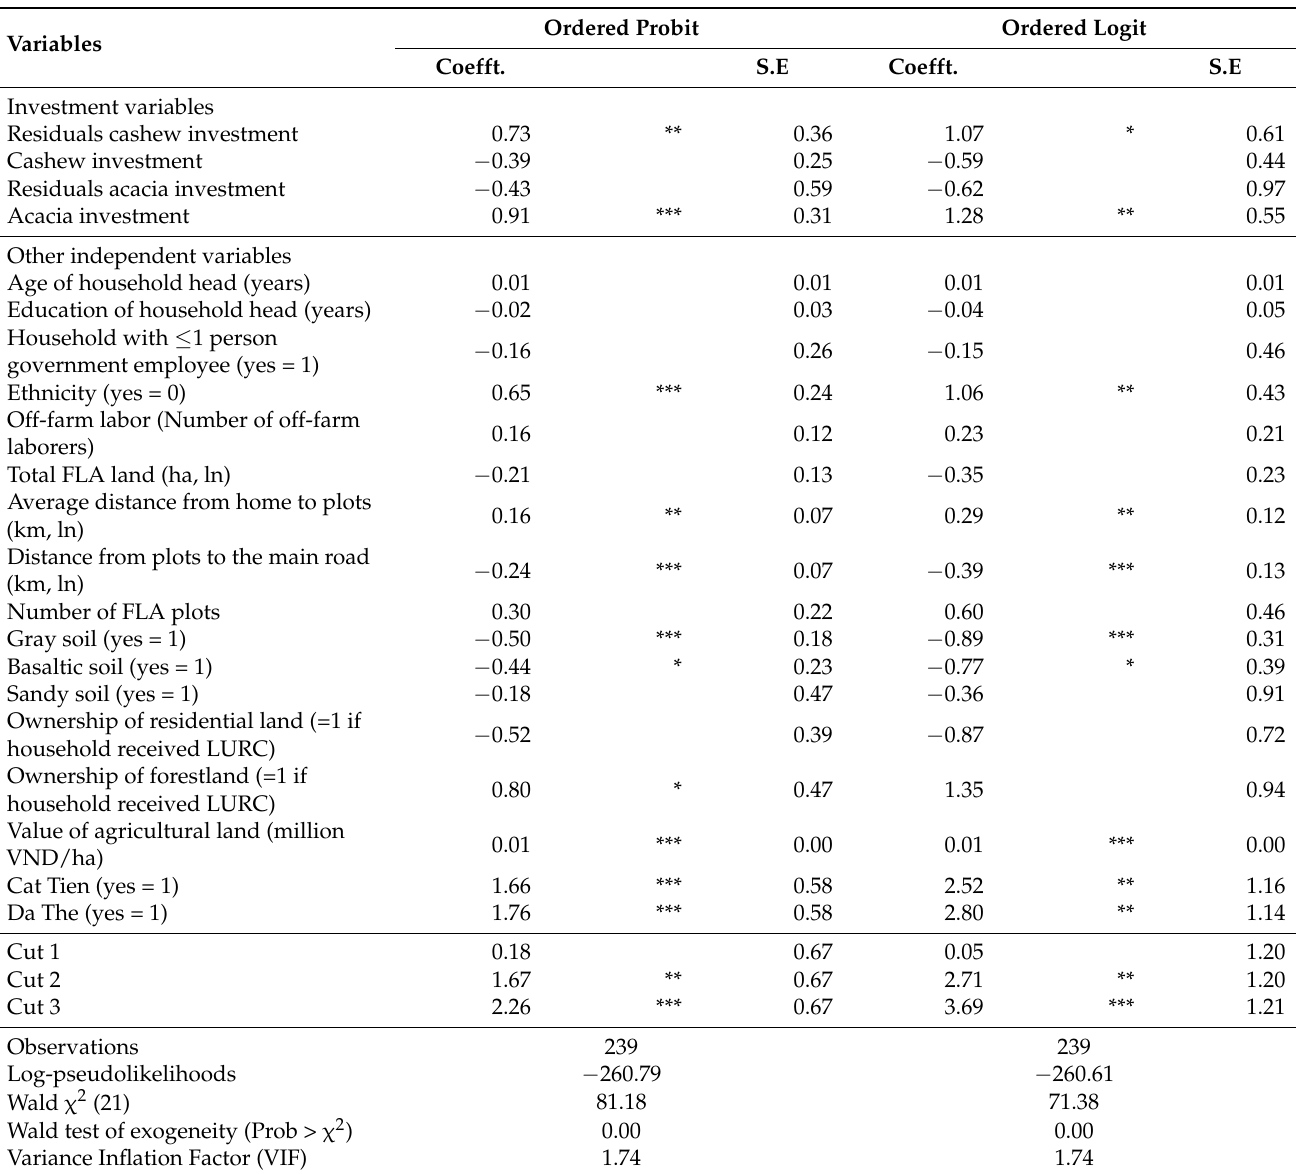
Table A4. Causal impact of investments of different tree choices on LTS